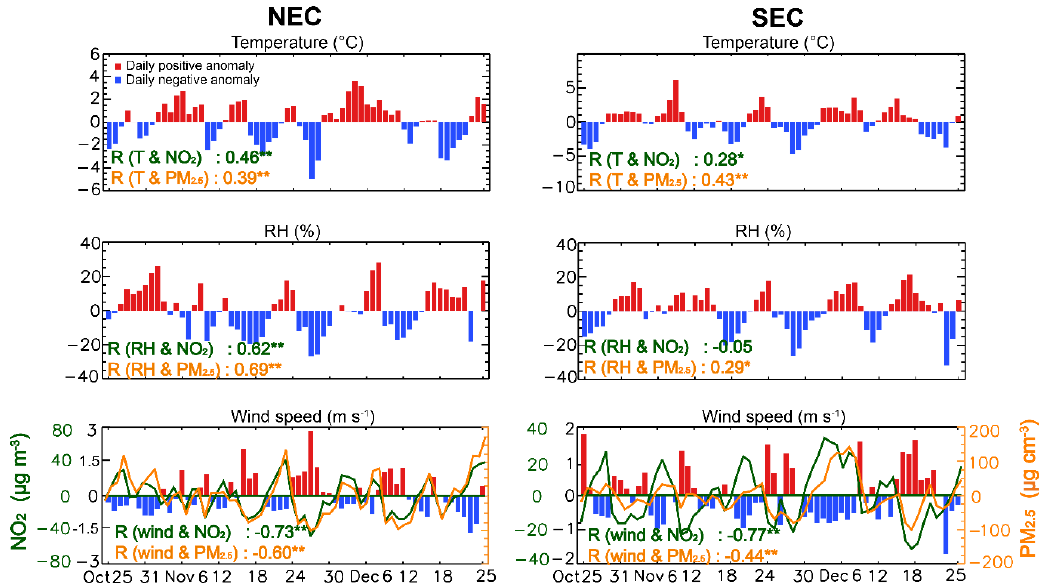
Figure 7. Daily anomalies of observed meteorological parameters and pollutant concentrations averaged over NEC and SEC, as well as their correlations. All data are de-trended. Correlation coefficients with “*” and “**” are statistically significant with P values below 0.05 and 0.01,